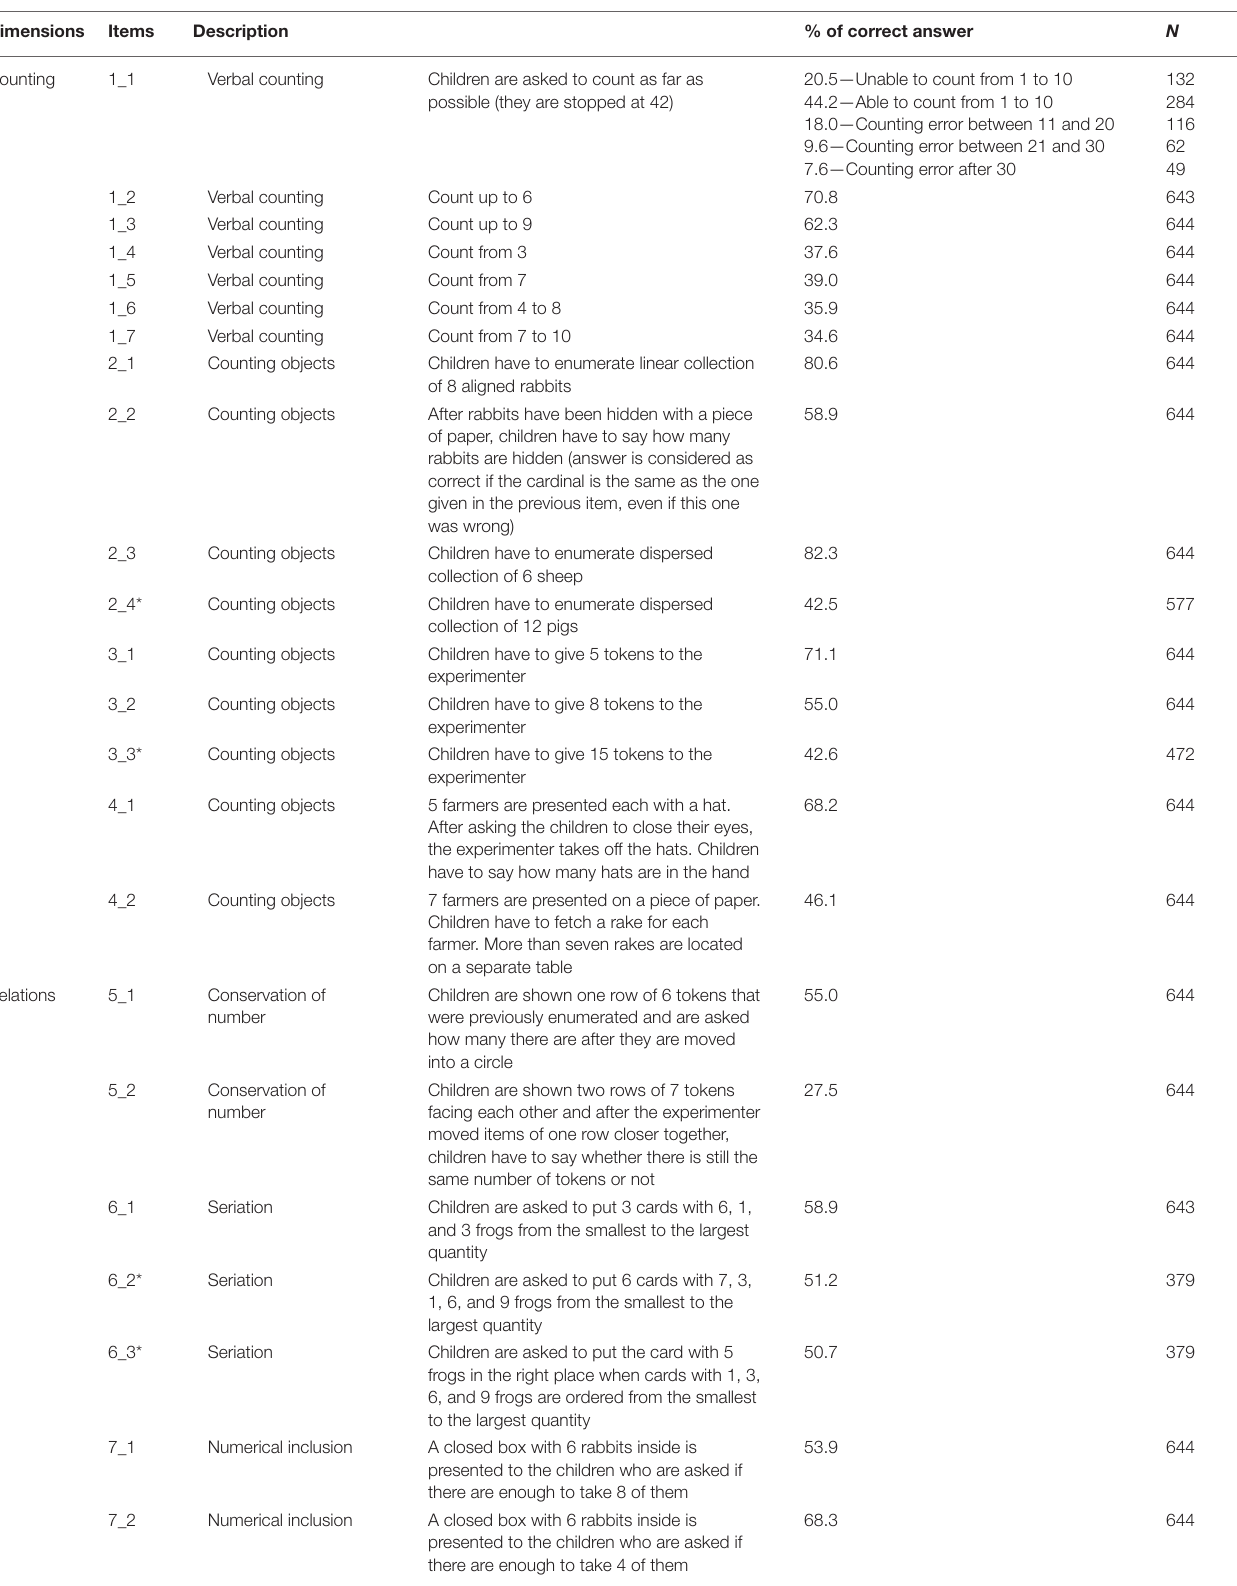
TABLE 1 | Description of the items used to measure early numerical ability. Dimensions Items Description % of correct answer